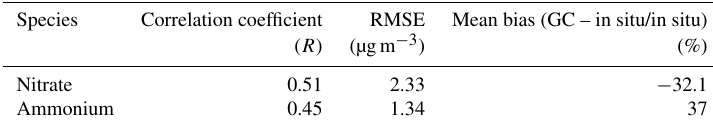
Table B1. The statistical evaluation ( R , RMSE, and mean bias) of the GC model performance (nitrate and ammonium in PM 2 . 5 ) for the 2019 study period (1 January to 31 May). For this comparison, data from the urban measurement station (51.75 ◦ N, 14.33 ◦ E) in Germany are